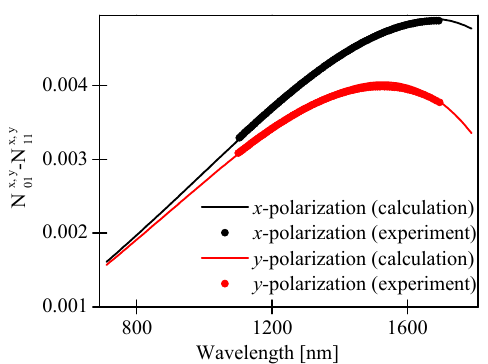
Figure 4. Calculated and measured difference in group effective indices of the LP 01 and LP 11 modes for both polarizations.